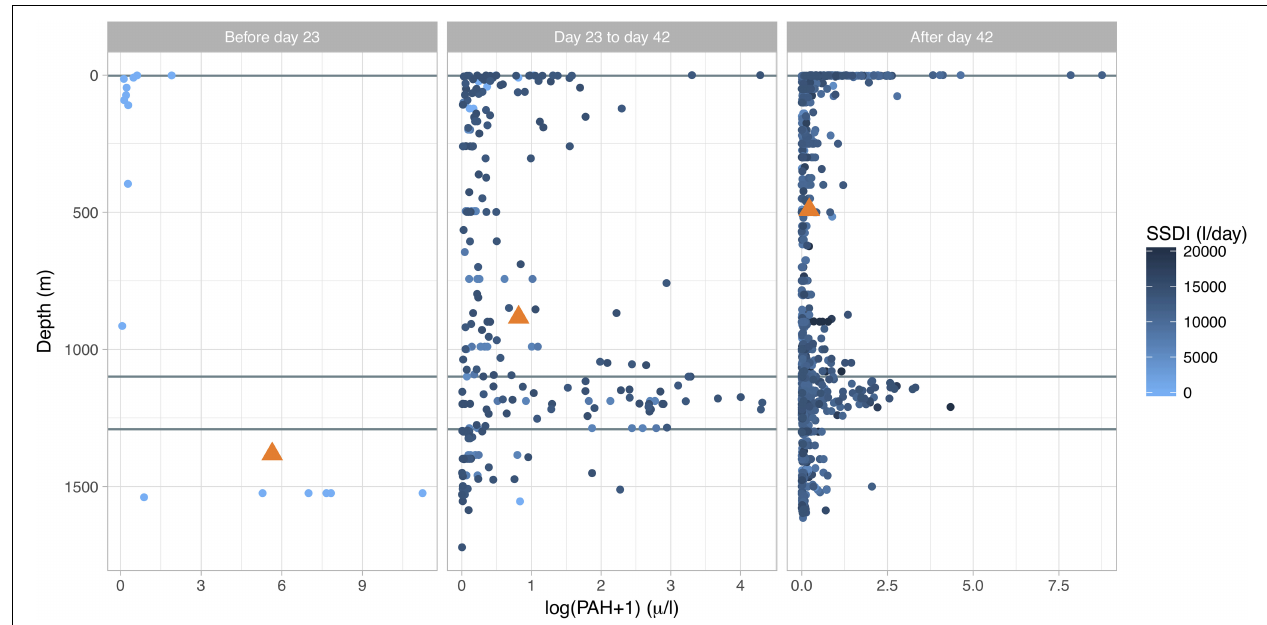
FIGURE 4 | Polycyclic aromatic hydrocarbon (PAH) concentration as a function of depth and Subsea Dispersant Injection (SSDI) volume (marker color). The panels correspond to the temporal splits (before and after day 23 and 42) from the hierarchical regression tree (RT) analysis of factors explaining the spatio-temporal variance in PAH concentrations (see Figure 3 ). The light blue lines correspond to the significant splits by depth (2, 1099, and 1291 m) in the RT analysis (see Figure 3 ). Orange triangles indicate the center of mass of the data points presented in each